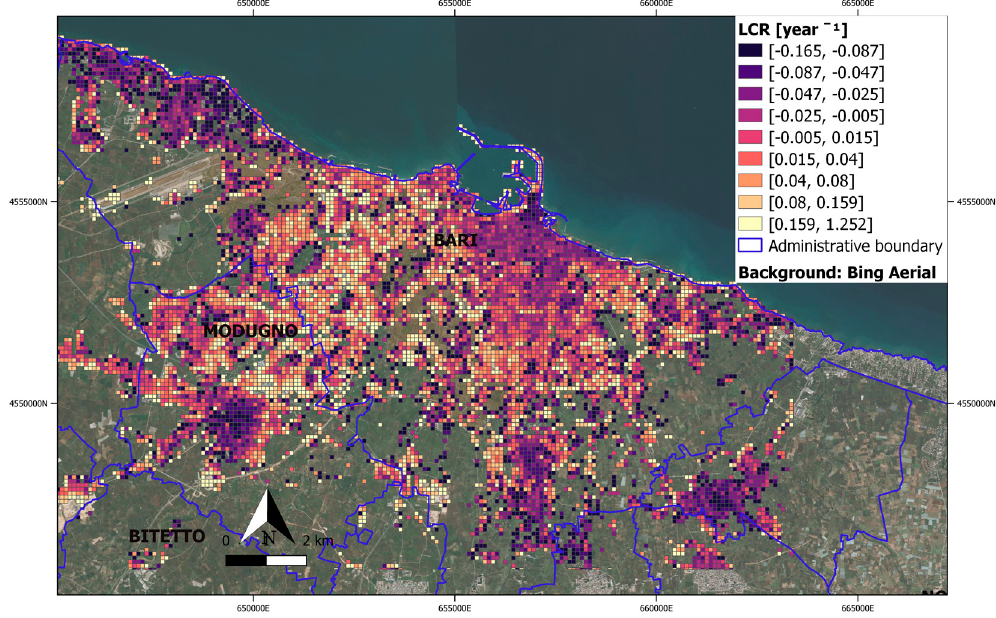
Figure 11. Land Consumption Rate by comparing the settlement map up to 2020 with ESM 2012.